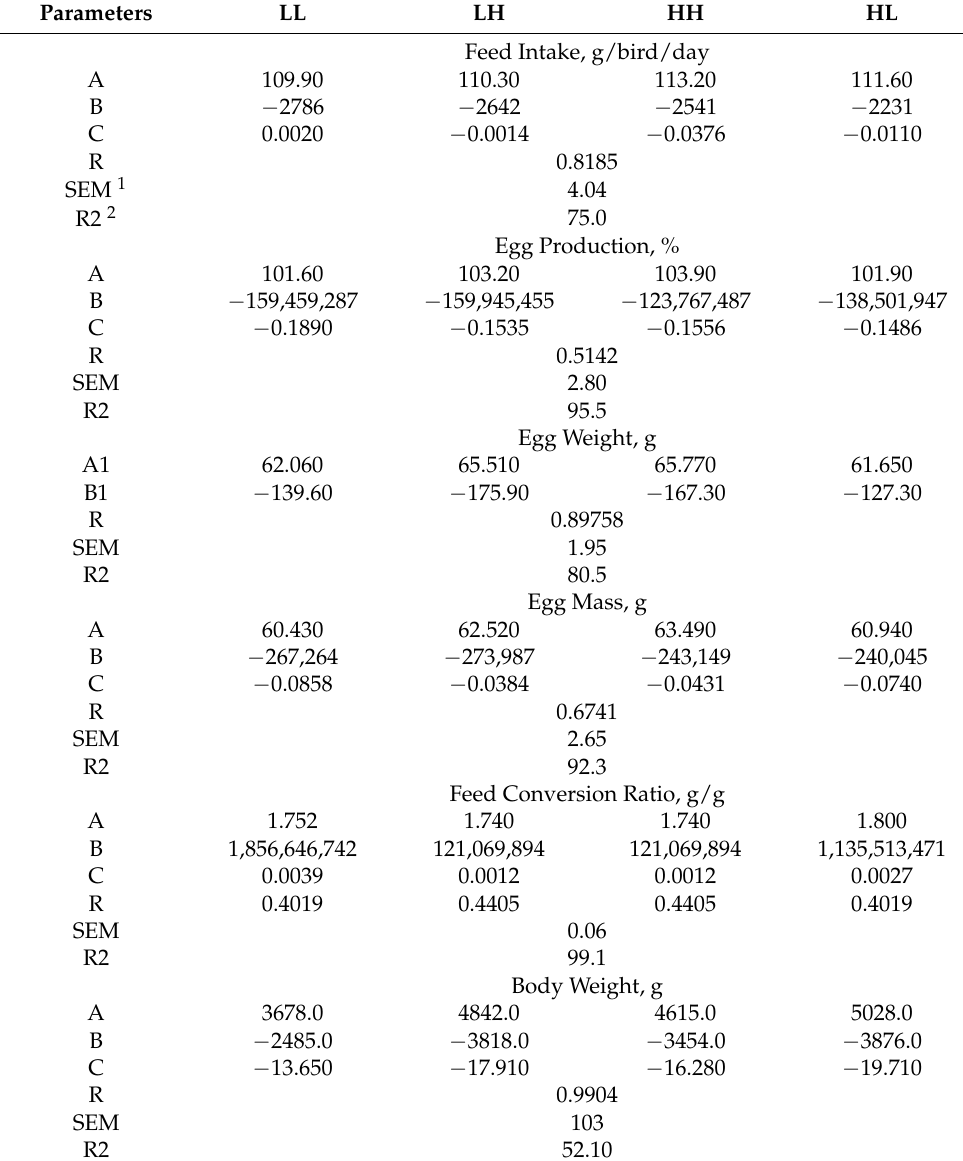
Table 6. Regression models to estimate the performance of laying hens from 19 to 102 weeks old consuming levels of dietary balanced protein (LL or HH), repleted (LH) and depleted feeds (HL). Parameters LL LH